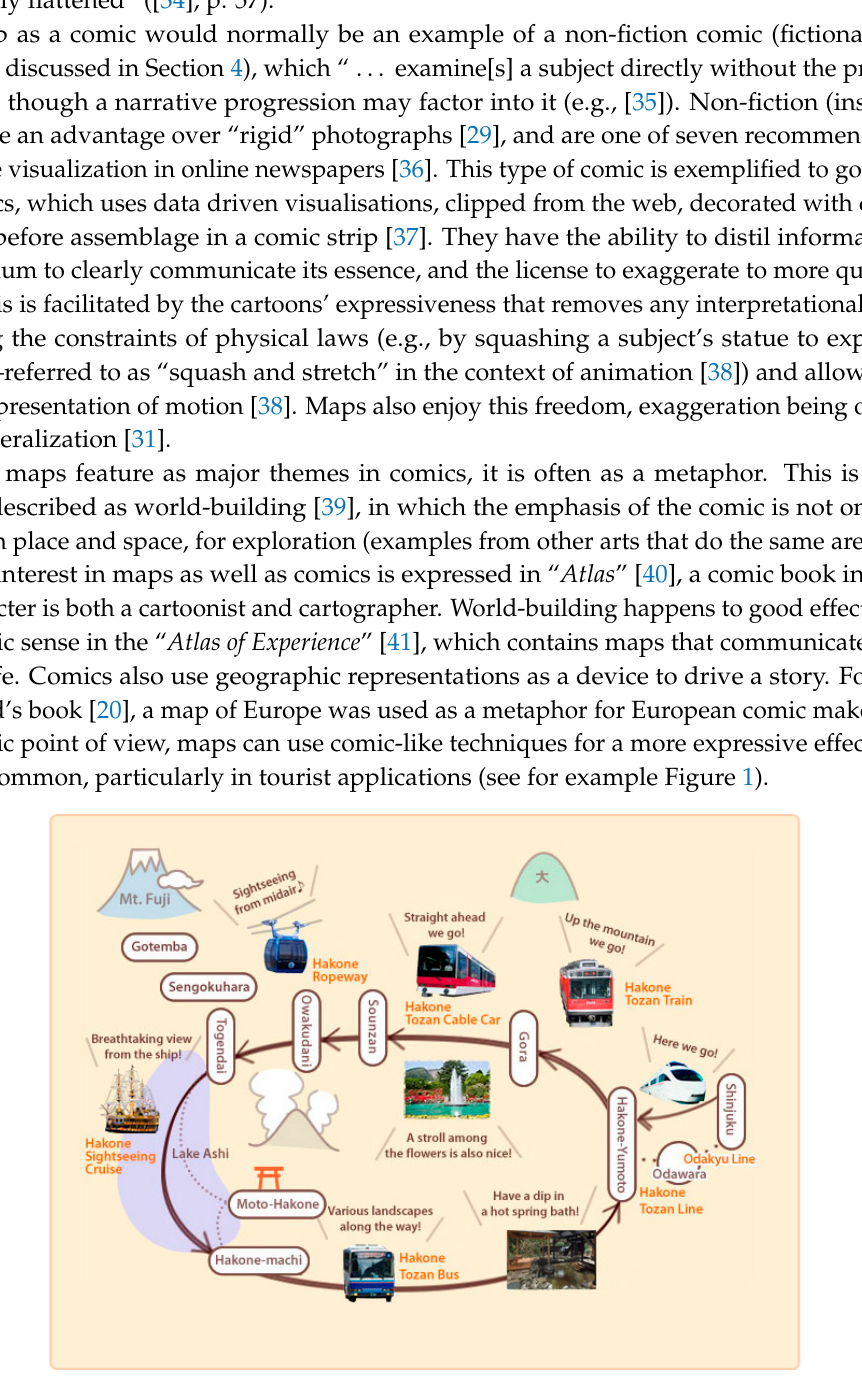
Figure 1. Example tourist attractions itinerary (source: https://www.hakonenavi.jp/english/basics/trip/).